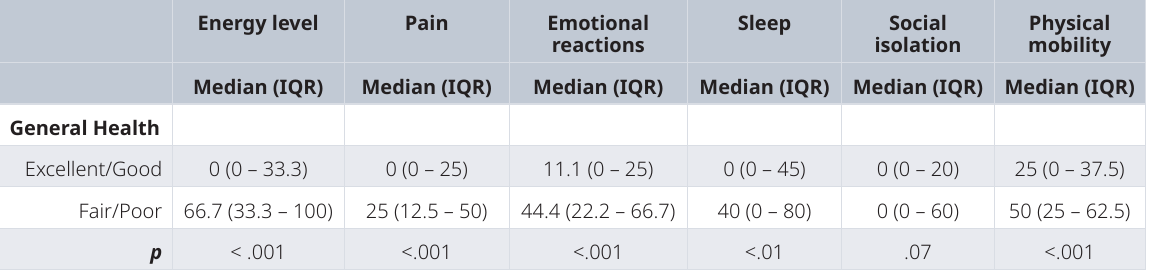
Table 6b. Median NHP section scores by perceived general health in pulmonary hypertension* patients.